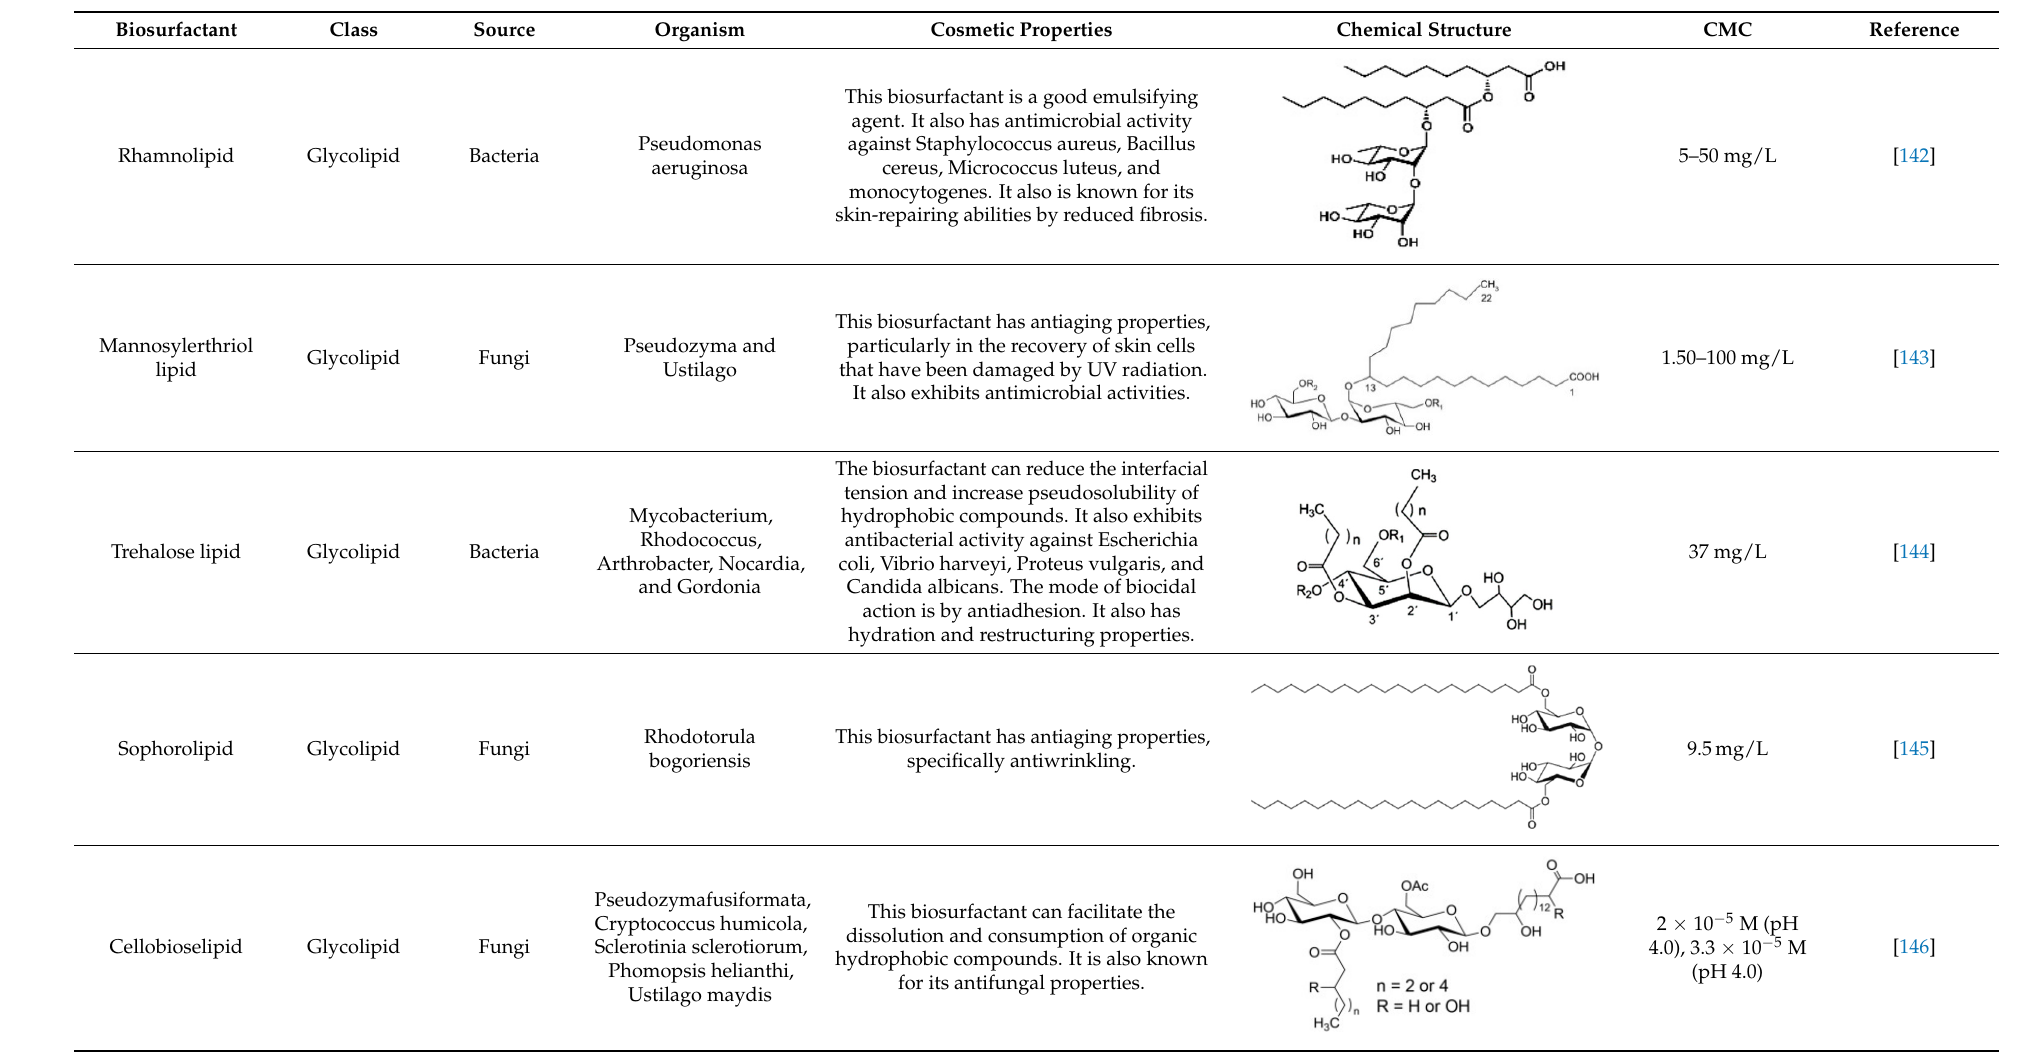
Table 3. Suggestive list of biosurfactants to be used in nanoemulsion.